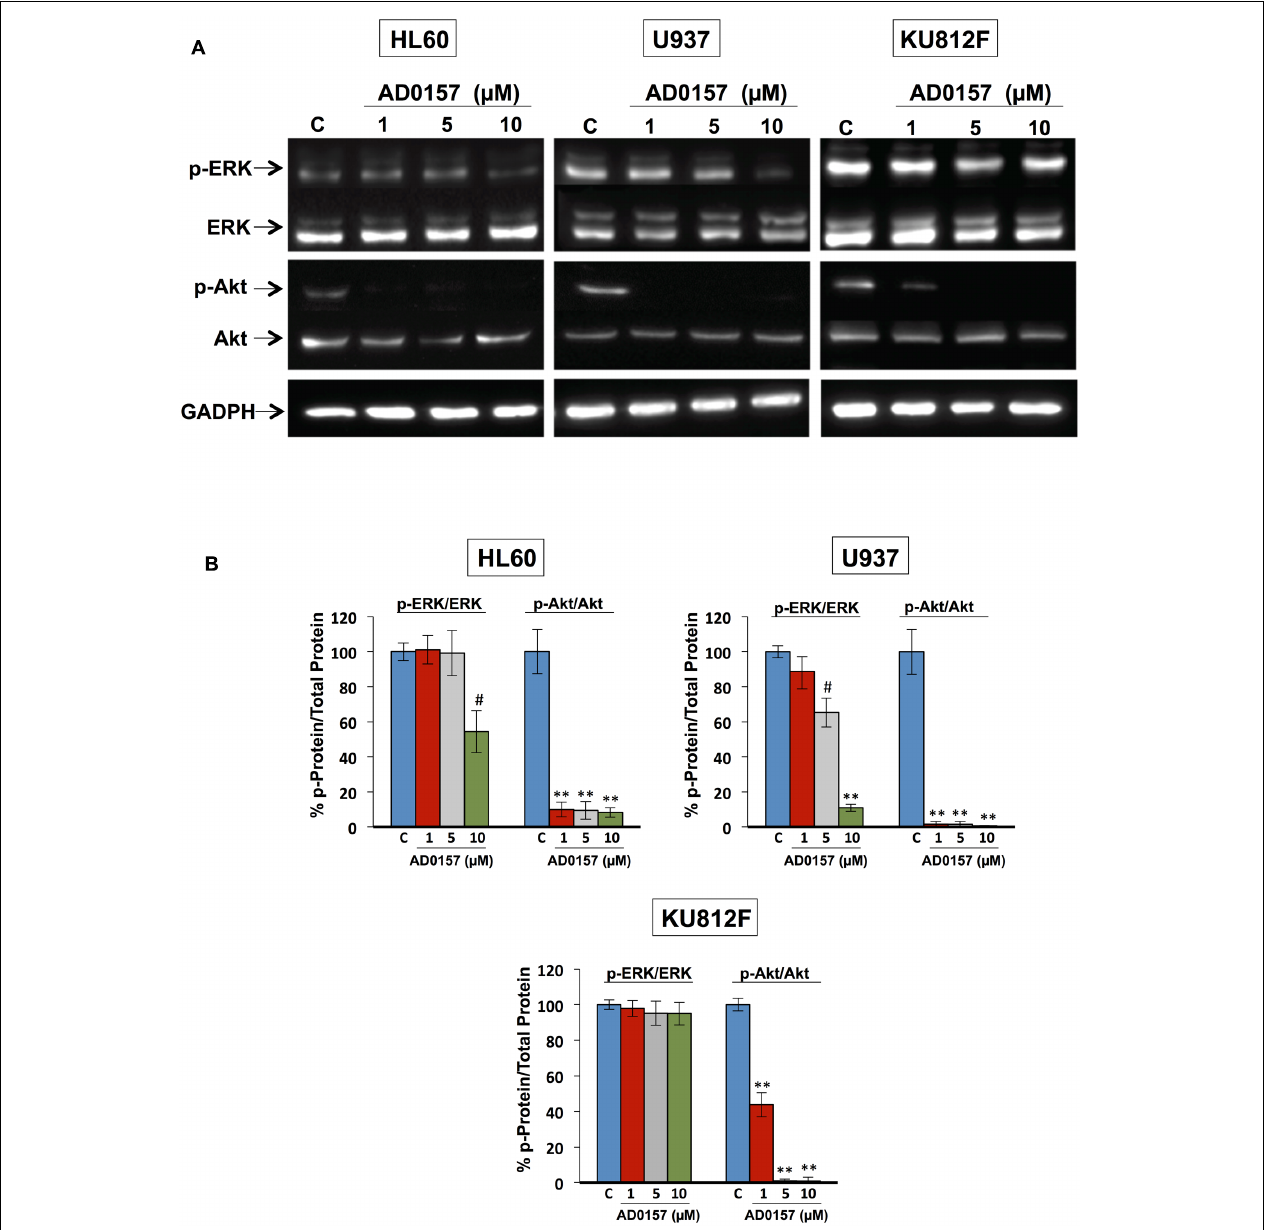
FIGURE 8 | Akt and ERK regulate the AD0157-induced apoptosis in human myeloid leukemia cells. (A) Representative blots of p-ERK, total ERK, p-Akt and total Akt in HL60, U937 and KU812F upon treatment (14 h) with the indicated concentrations of AD0157 and stimulation with FBS 20% (30 min). (B) Percentage of p-ERK/ERK and p-Akt/Akt ratios in untreated and treated cells, expressed as means ± SD of three independent assays. # p < 0.005 and ∗∗ p < 0.001 versus